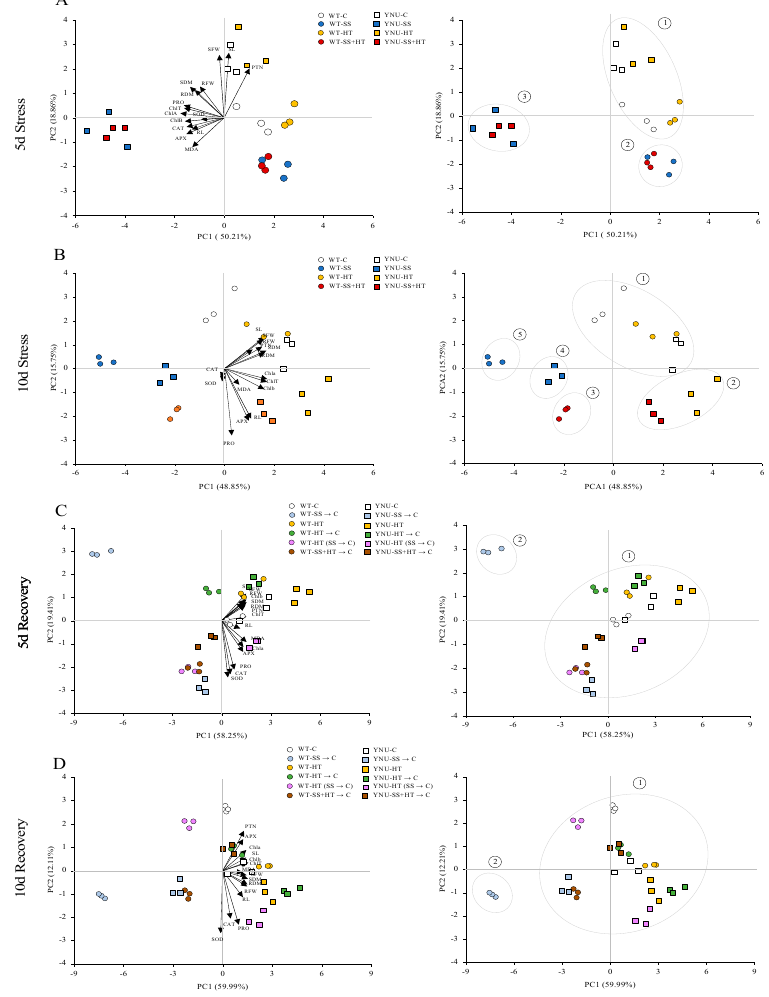
Figure 7. Principal component analyses (PCA) of WT and YNU traits under ( A ) DAT5; 5 days of stress, ( B ) DAT10; 10 days of stress, ( C ) DAT15; 5-day stress-release recovery, and ( D ) DAT20; 10-day stress-release recovery.